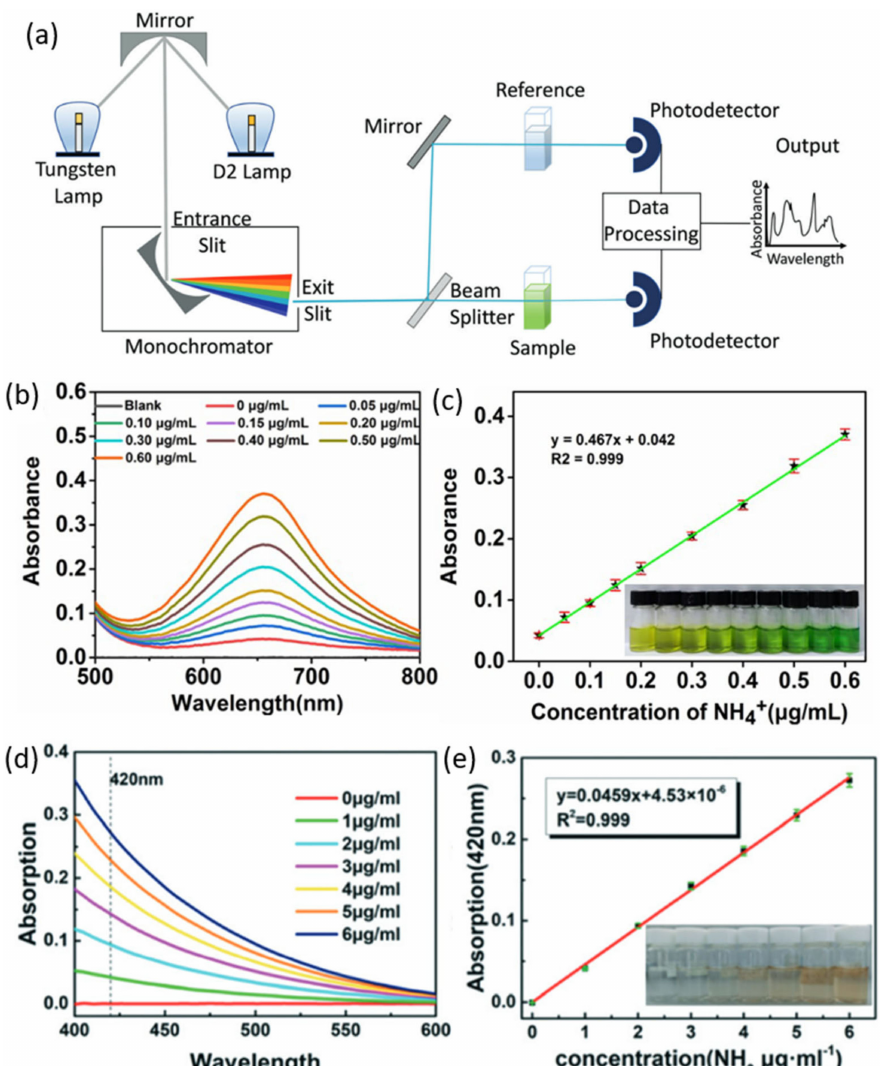
Figure 3. ( a ) Schematic illustration of UV-vis spectrophotometer for double beam instrument. The tungsten lamp and D2 lamp emit visible and ultraviolet lights, respectively. The light is directed to the monochromator, which determines the wavelength of the sample. Adapted with permission from Ref. [41] Copyright 2018, Wiley-VCH. Ammonia determination using indophenol blue method, ( b ) UV-vis spectra of standard solutions with different concentrations, and ( c ) corresponding cali- bration curve. The absorbance values for the calibration curve were obtained from a wavelength of 655 nm. Inset of ( c ) is the photograph of the standard solutions after 2 h of reaction with indophenol reagent. Adapted with permission from Ref. [45] Copyright 2021 Royal Society of Chemistry. Ammo- nia determination using Nessler’s method. ( d ) UV-vis spectra of the standard solution with different concentrations, and ( e ) corresponding calibration curve. The absorbance values for the calibration curve were obtained from the wavelength of 420 nm. Inset of ( e ) is the photograph of the standard solution after 20 min of reaction with Nessler’s reagent. Adapted with permission from Ref.